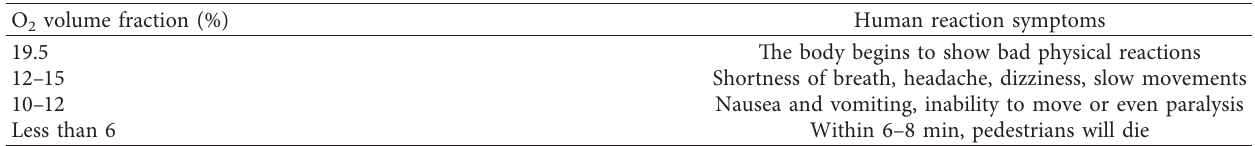
Table 3: Effects of O 2 on the human body.